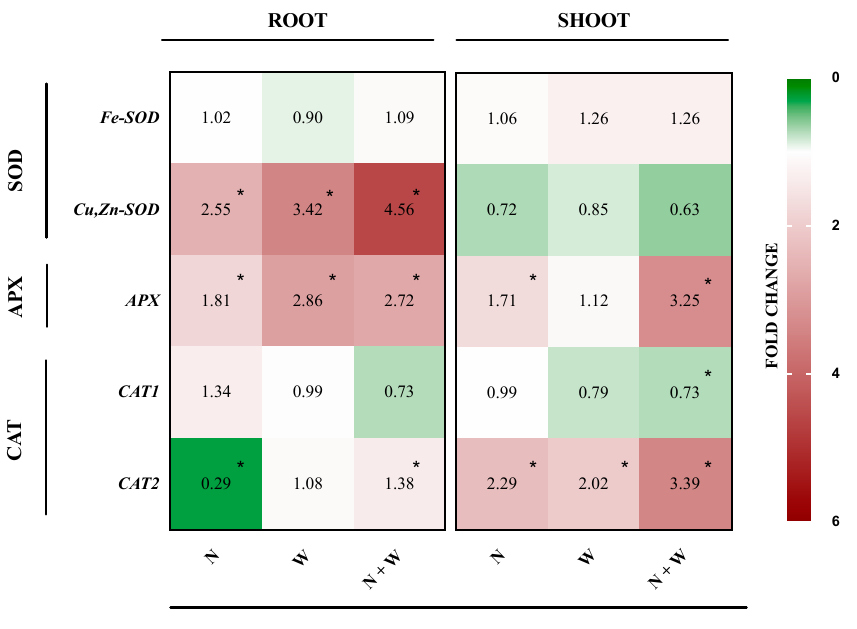
Figure 6. Relative fold of expression of antioxidant system-related genes in tomato (cv. Micro-Tom) roots and shoots as affected by nitrogen deficit (N; 5.3 mM N + 100% W), water deficit (W; 10.5 mM N + 50% W) or combined nitrogen and water deficit (N + W; 5.3 mM N + 50% W). The 2 − ∆∆ Ct values against the control are shown ( n = 3). * Values indicate significant differences compared to control according to the t-test ( p = 0.05). Green color indicates downregulation and red color upregulation compared to the control plants.